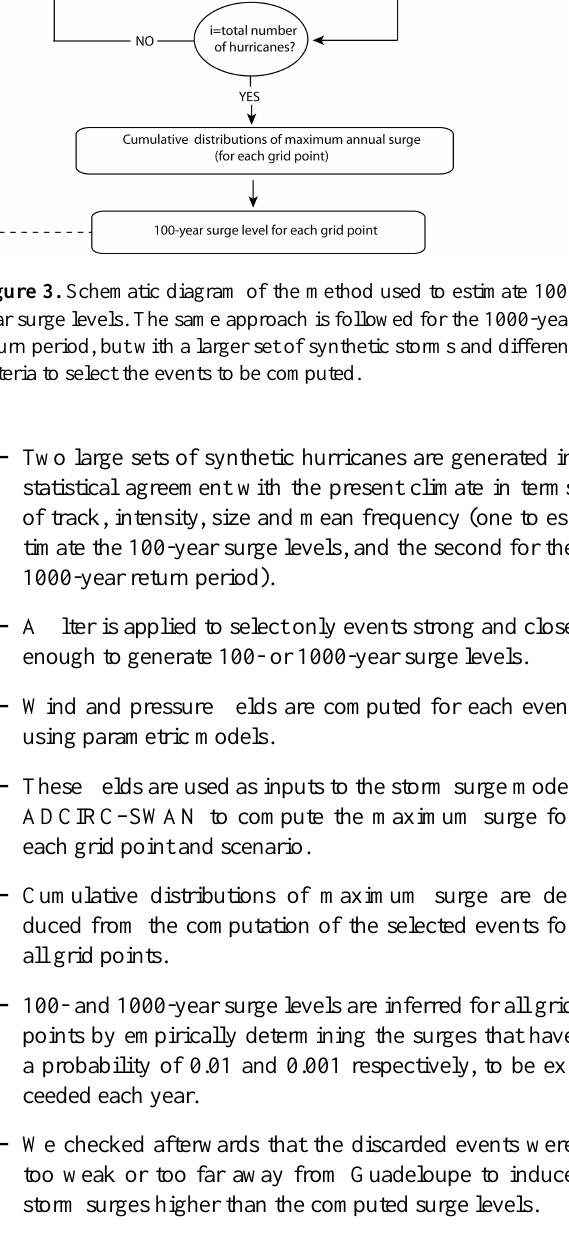
Figure 4. Number of events as a function of hurricane category. Note that the number of category 1 hurricanes is under-represented in data set 2 (equivalent to 50000 years of hurricane activity) com- pared to data set 1 (8000 years of activity), since the weakest cate- gory 1 events are not considered in this data